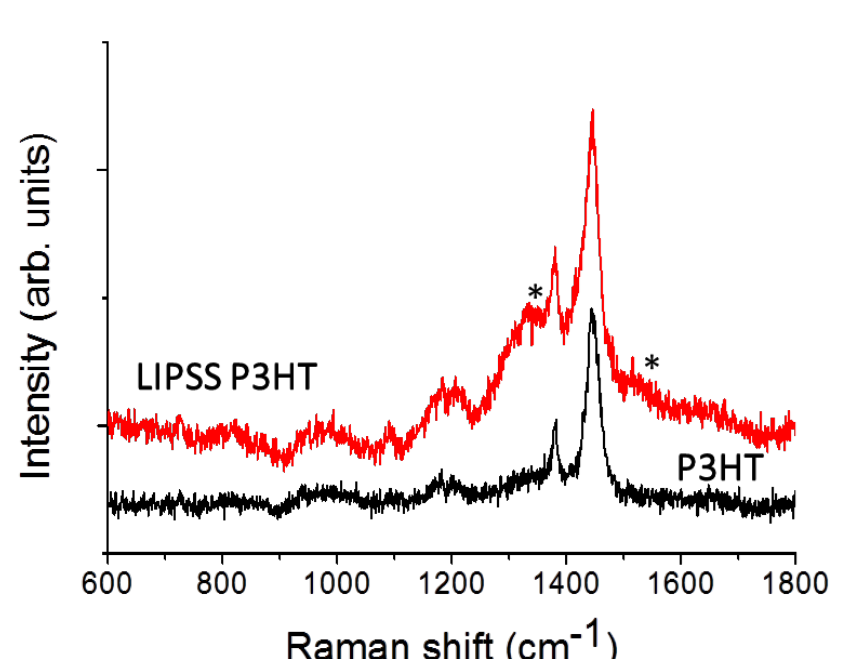
Figure A2. Raman Spectra of P3HT and of the P3HT LIPSS sample after irradiation at 266 nm in ambient conditions. The new bands appearing upon irradiation are indicated by asterisks.